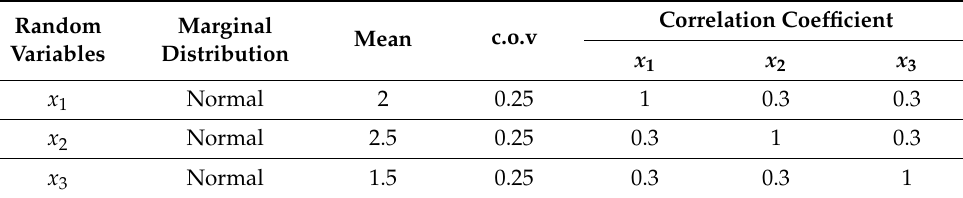
Table 1. Description of the random variables for the comparative study.